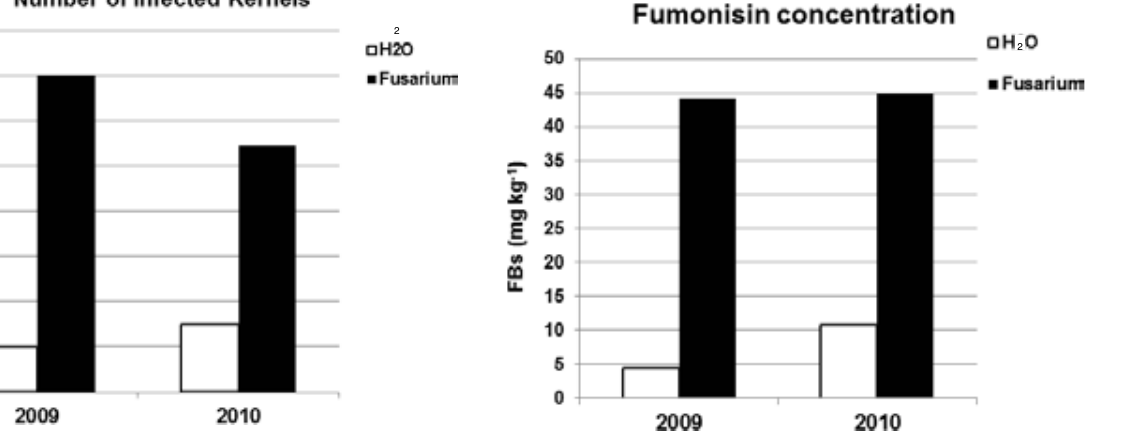
Figure 2. Average Number of Infected Kernels (NIK) for 40 inbred maize lines inoculated with sterile water (□ H 2 O) and with F. verticillioides (  Fusarium ) in 2009 (LSD 0.01 : 0.82) and 2010 (LSD 0.01 : 2.73) at CRA-MAC.